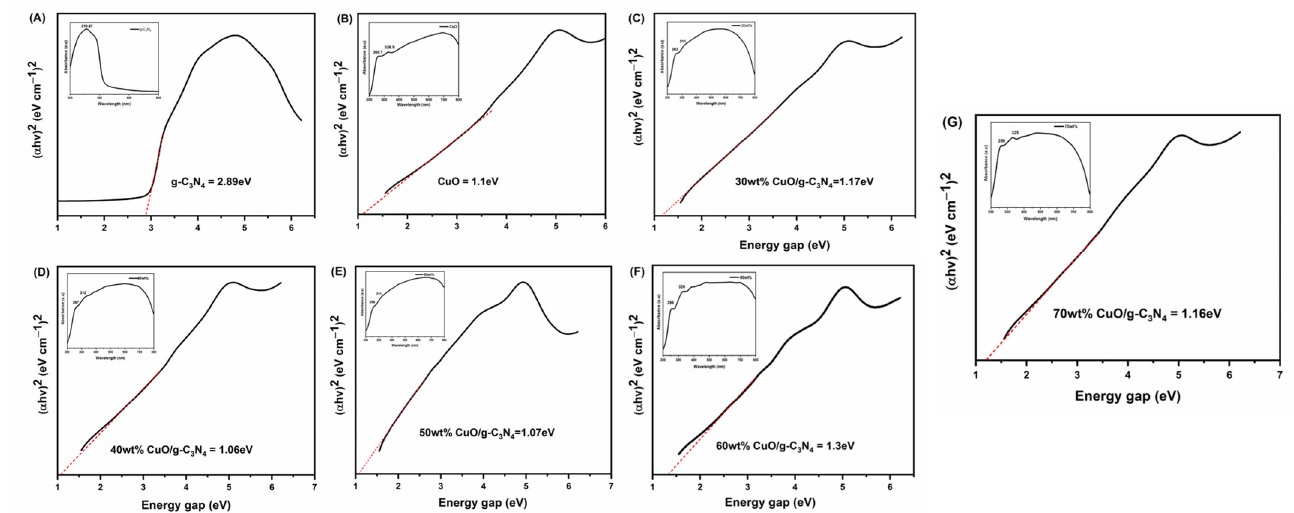
Figure 5. UV-DRS spectra exhibit band gap energy of exfoliated g -C 3 N 4 ( A ), CuO ( B ), and CuO loaded g -C 3 N 4 ( C – G ); (inset: absorption peak). (Bold black line represented by UV-DRS and dotted line noted by bandgap measurement line).